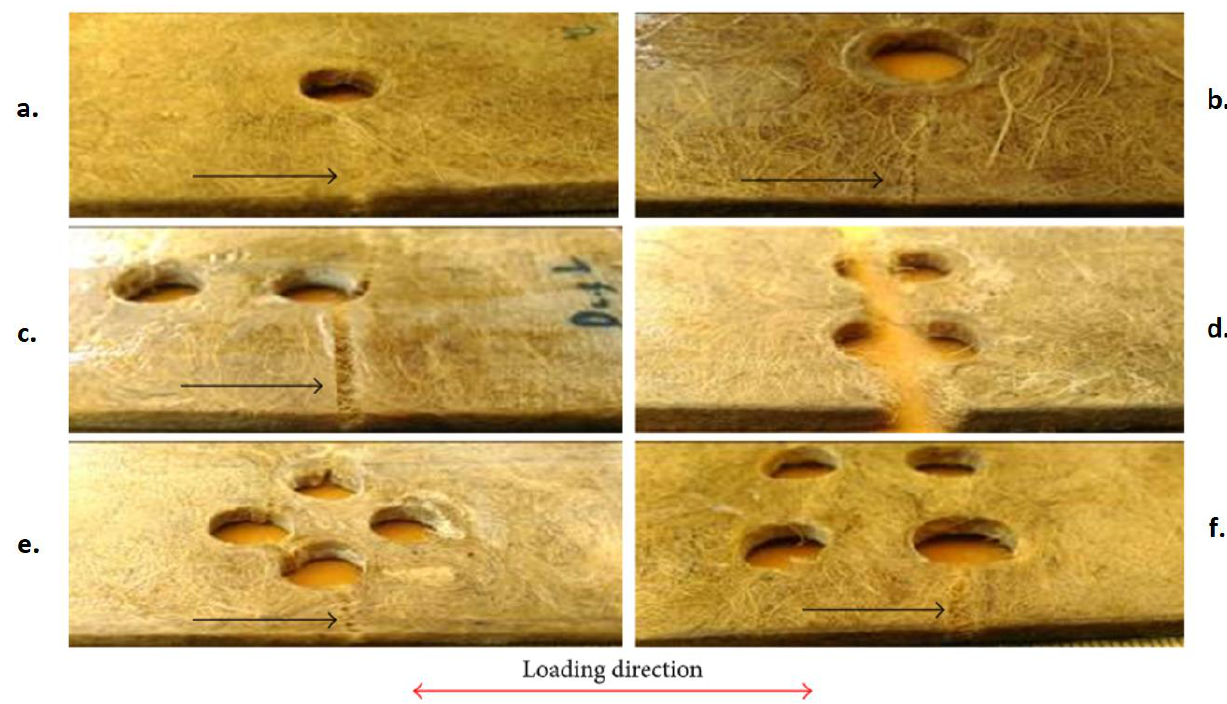
Figure 2. Hole patterns of the lontar fiber/polyester composites and their corresponding failures: ( a , b ) central hole of 5 mm, ( c ) 2 holes parallel to the loading axis, ( d ) 2 holes perpendicular to the loading axis, ( e ) 4 holes in diamond pattern, and ( f ) 4 holes in square pattern [85].